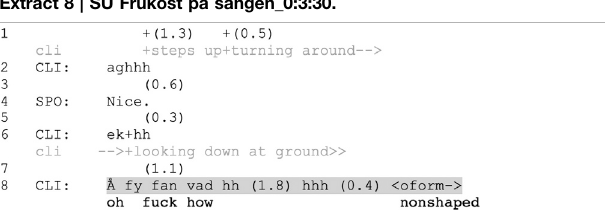
Extract 8 | SU Frukost på